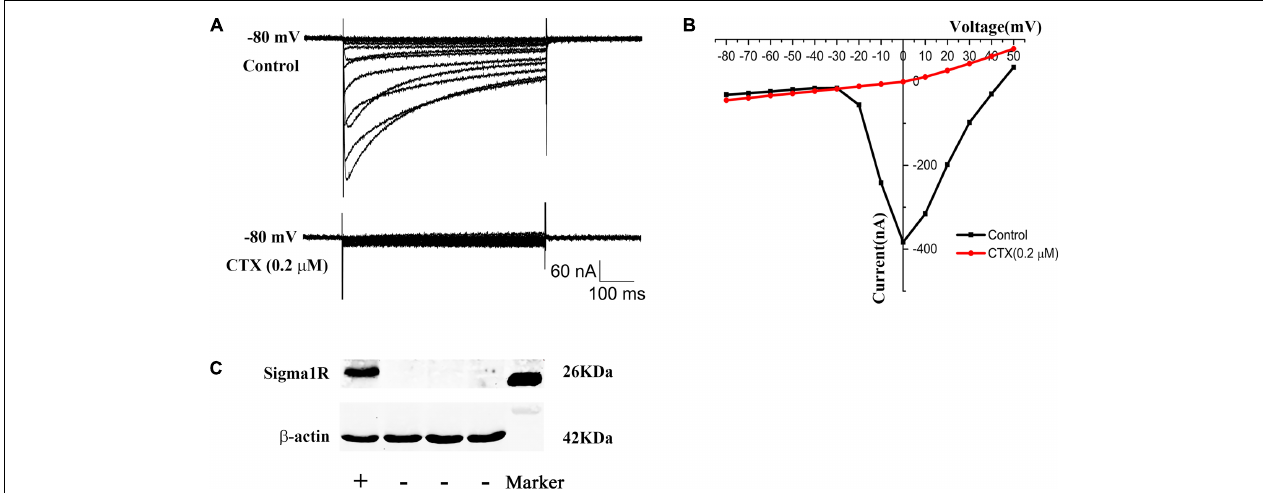
FIGURE 3 | Expression of N-type Ca 2 + channel and sigma-1 receptor in xenopus oocytes. (A) Upper panel: the current of N-type Ca 2 + channel recorded in oocytes after microinjection with N-type Ca 2 + channel cRNA. Lower panel: the current was blocked by N-type Ca 2 + channel blocker CTX (0.2 µ M). (B) I–V plot of the recorded N-type Ca 2 + channel current in (A) . (C) Schematic Western blot strap of oocytes injected with sigma-1 receptor cRNA (the first lane) and control group (the middle three lanes), which indicated the sigma-1 receptor expressed successfully. The last lane showed the Marker.